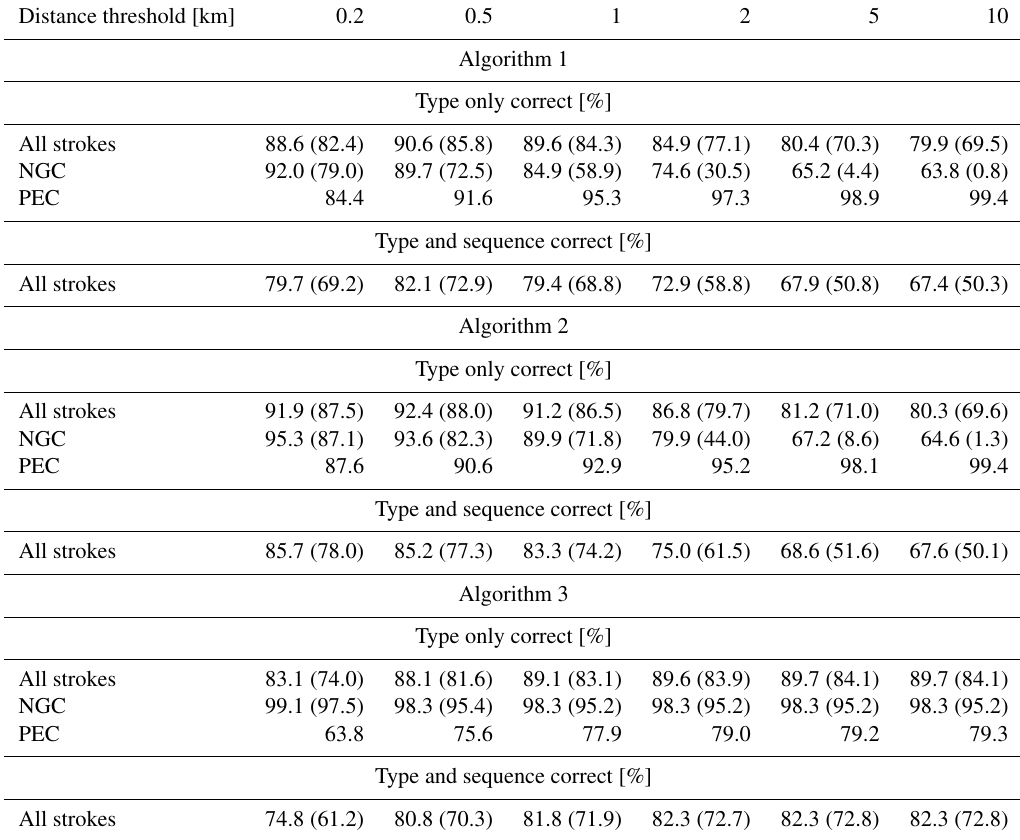
Table 2. Performance results for the three algorithms excluding BR, i.e., black curve in Fig. 2. Values in parentheses are success rates for events without the first strokes, i.e., removing all single-stroke flashes as well as the first strokes in the multiple-stroke flashes. Distance threshold [km]